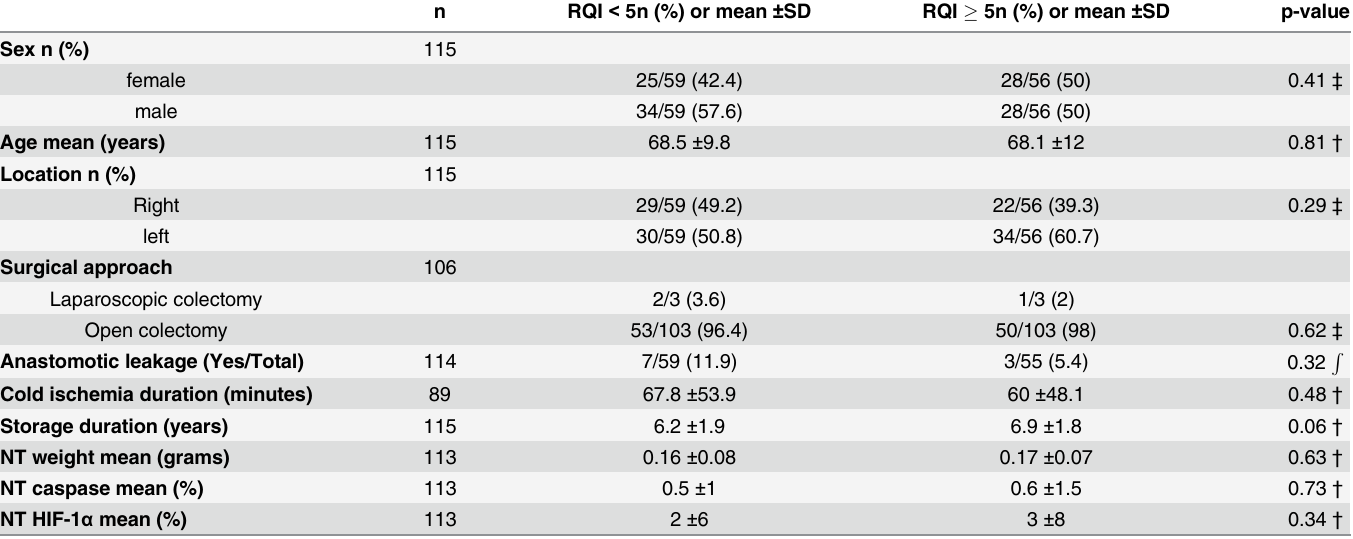
Table 2. Parameters associated with RNA quality in non tumoral colonic